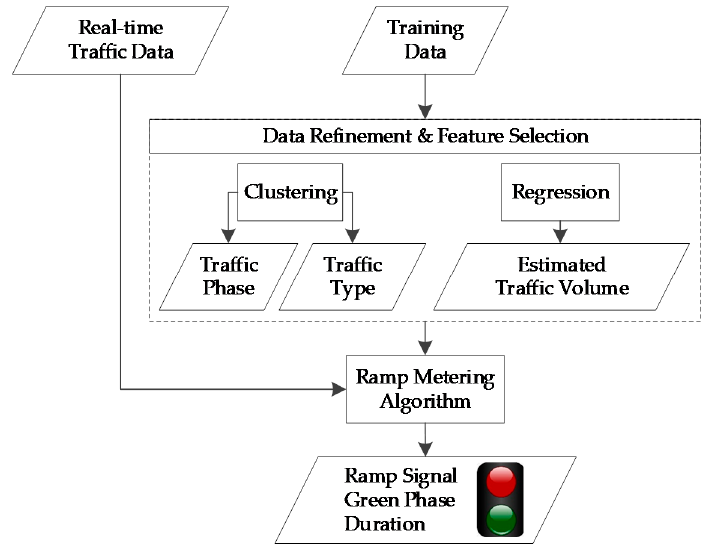
Figure 3. The general schema of proposed algorithm.